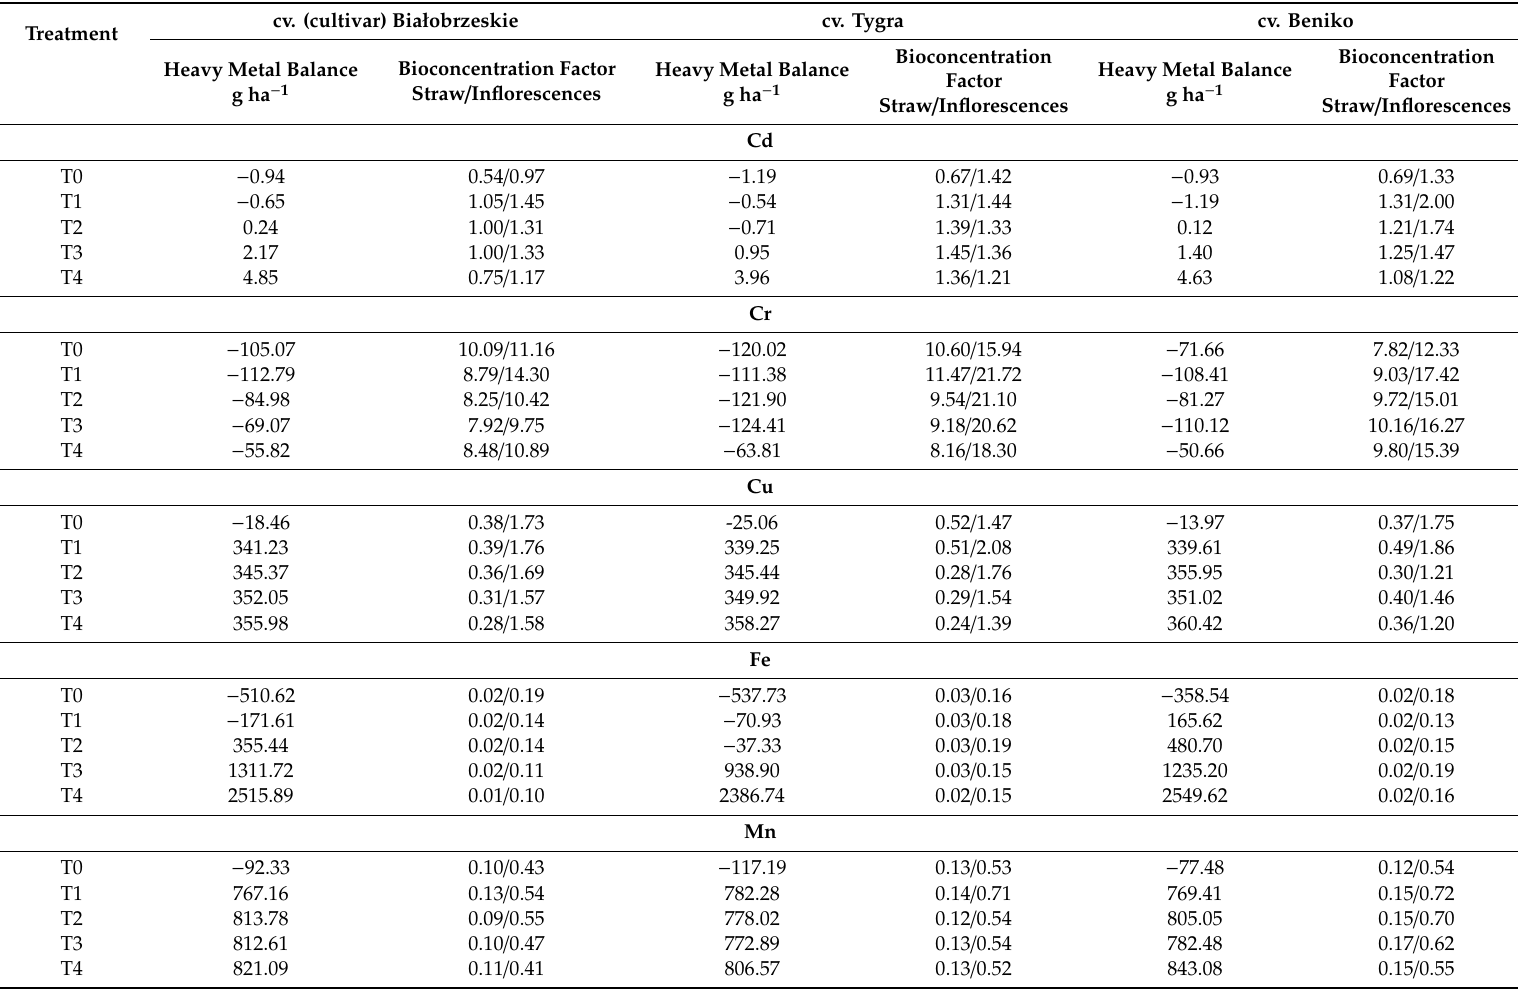
Table 1. Impact of soil amendments on bioconcentration factors and balances of heavy metals.